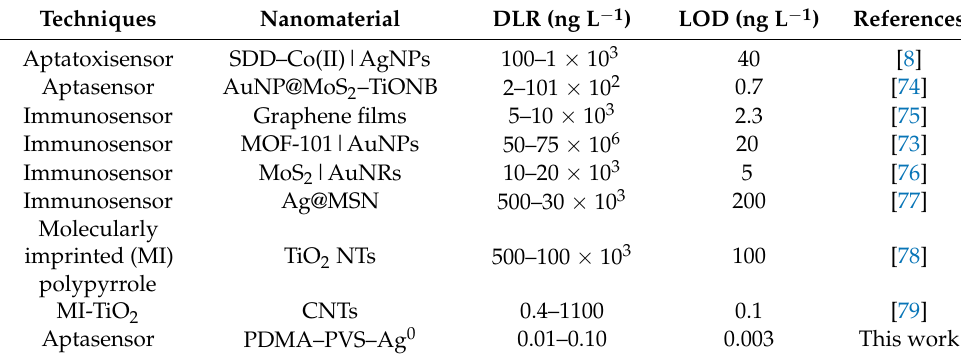
Table 1. Comparison of the parameters of MC-LR